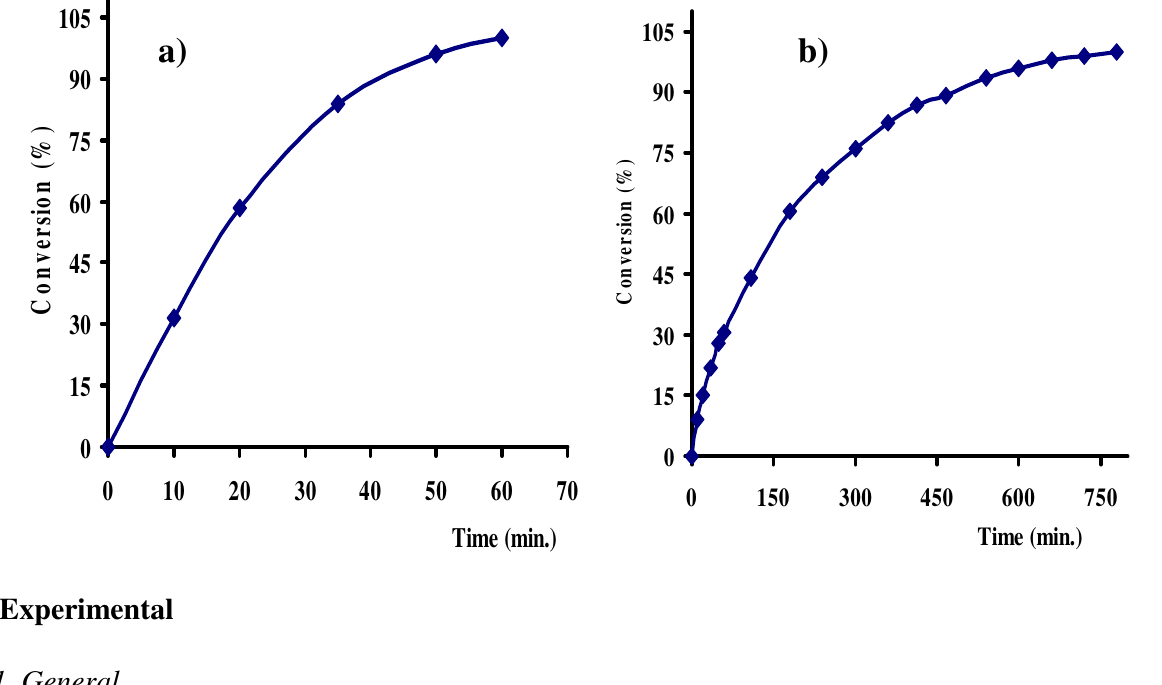
Figure 10. Hydrogenation reaction of trans -4-phenyl-3-butene-2-al using complex 1 and xerogel X1 catalysts under the above mild